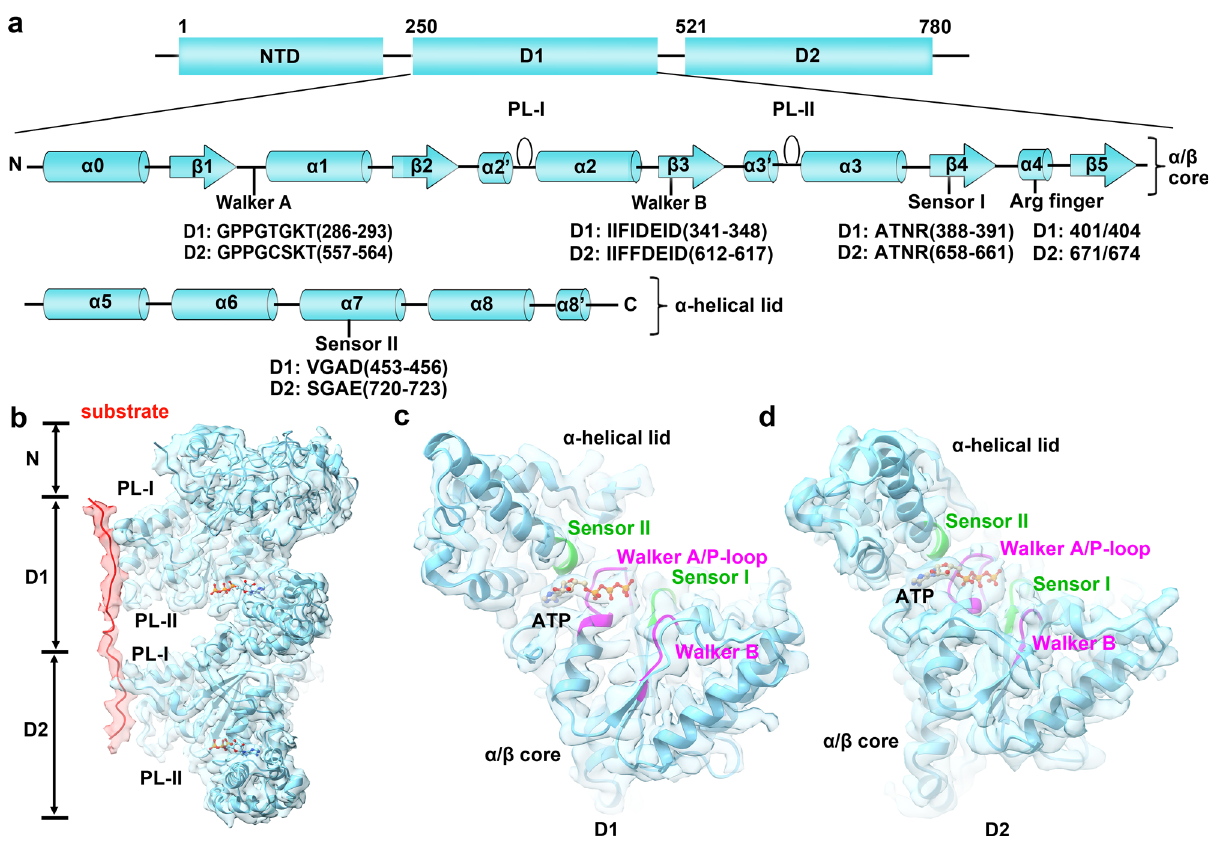
Fig. 3 | Atomic model and domain organization of Drg1. a Domain organization and secondary structure of S. cerevisiae Drg1. The AAA+domain contains an α / β core subdomain ( α 0- β 5) and an α -helical lid subdomain ( α 5- α 8). The highly con- servedmotifsincluding WalkerA,Walker B,sensor I, sensorII and arginine fi ngers, pore loops (PL-I and PL-II) are shown as indicated. b The atomic model of Drg1 is shown in cartoon representation, superimposed with the density map of one